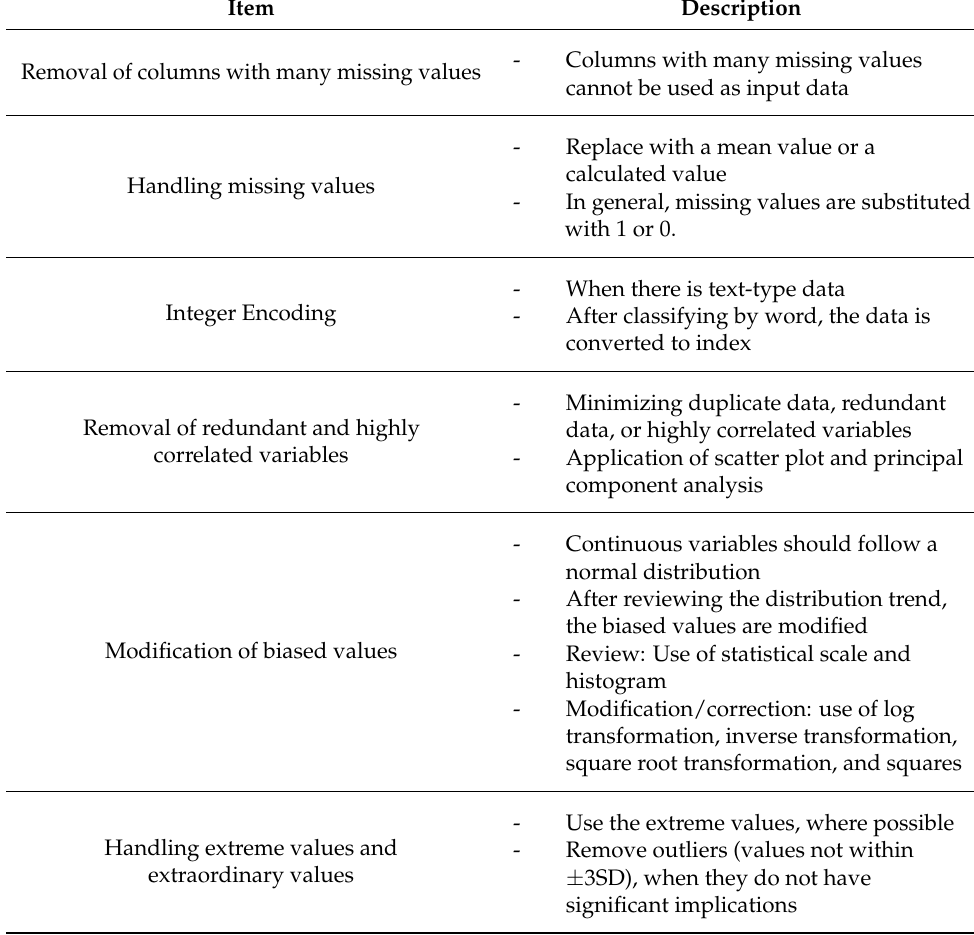
Table 6. Feature engineering for data